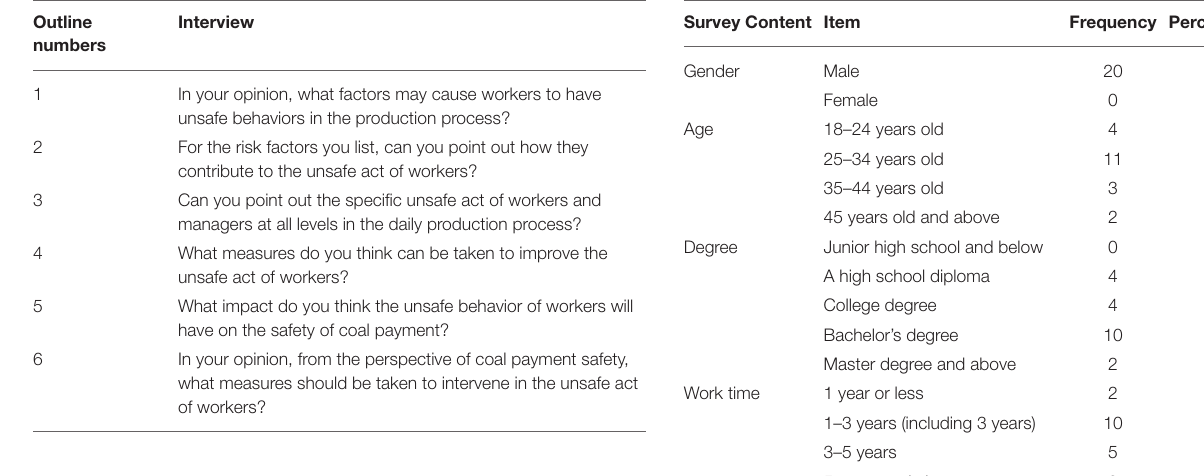
TABLE 3 | Sociodemographic characteristics of